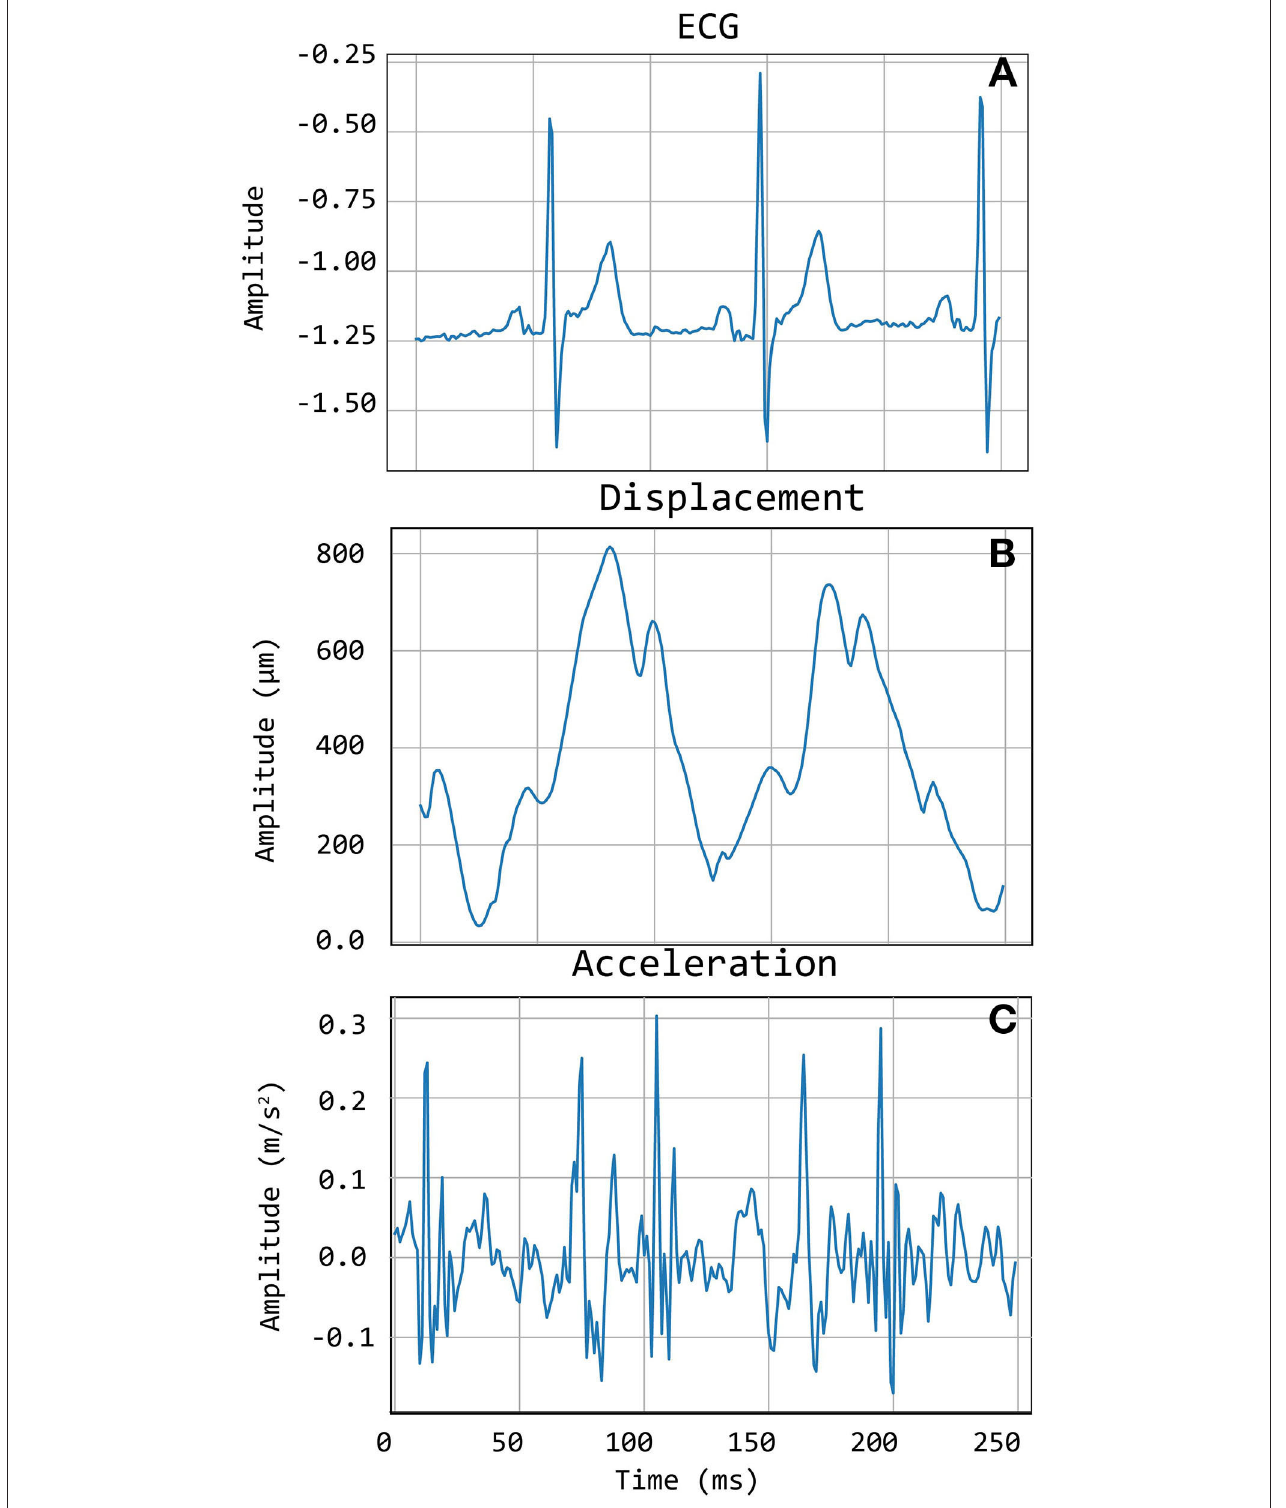
FIGURE 2 | An example of Cardis data. (A) shows the ECG signals, (B) shows the displacement signal, and (C) the corresponding acceleration signal.